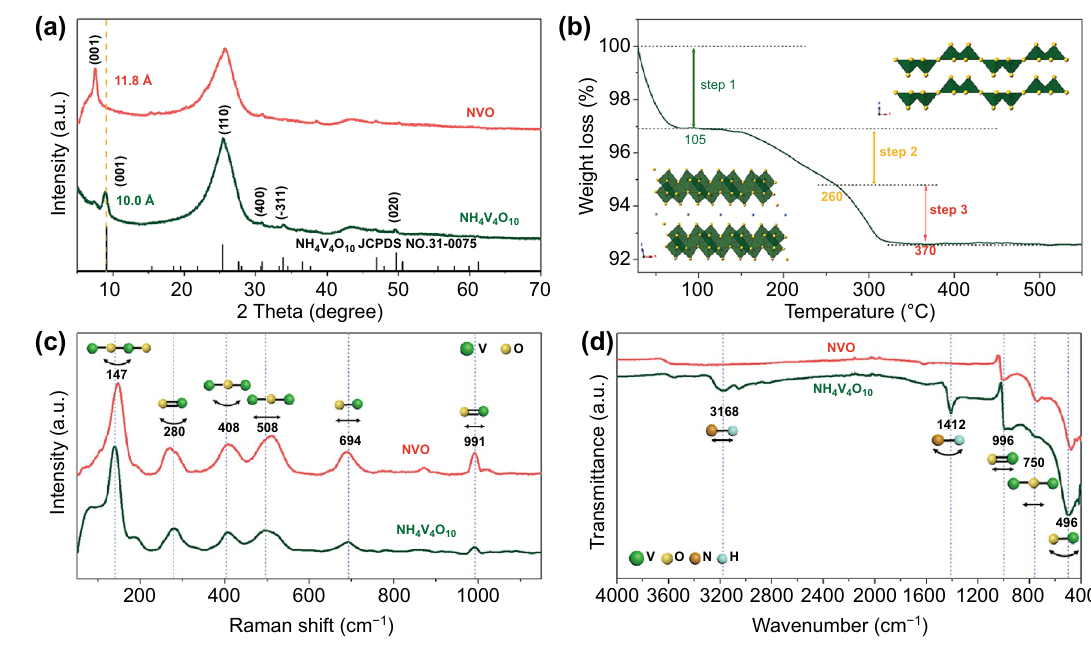
Fig. 1 Phase and structural characterization of NH 4 V 4 O 10 and NVO. a XRD patterns. The (001) peak in NVO shifts toward a low angle, indicat- ing a large interlayer spacing. b TGA analysis of NH 4 V 4 O 10 . The inset is the crystal structures of bi-layered NH 4 V 4 O 10 and single layered V 2 O 5 . c Raman and d FTIR spectra, the similar spectra indicate similar VO framework in two samples while the peak changes originate from the loss NH + of